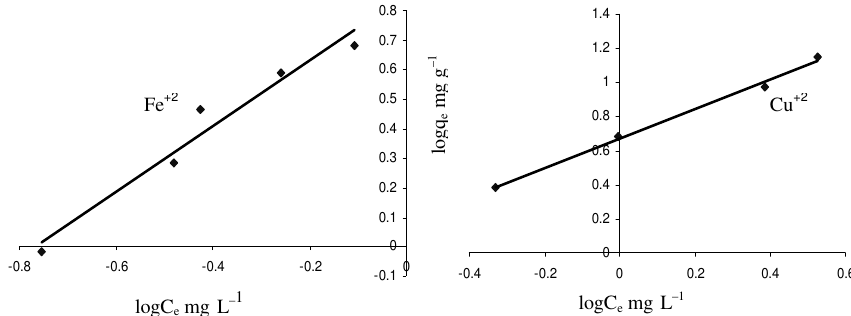
Figure 6 . Freundlich isotherm for adsorption of copper and ferrous ions onto pine fruit powder.